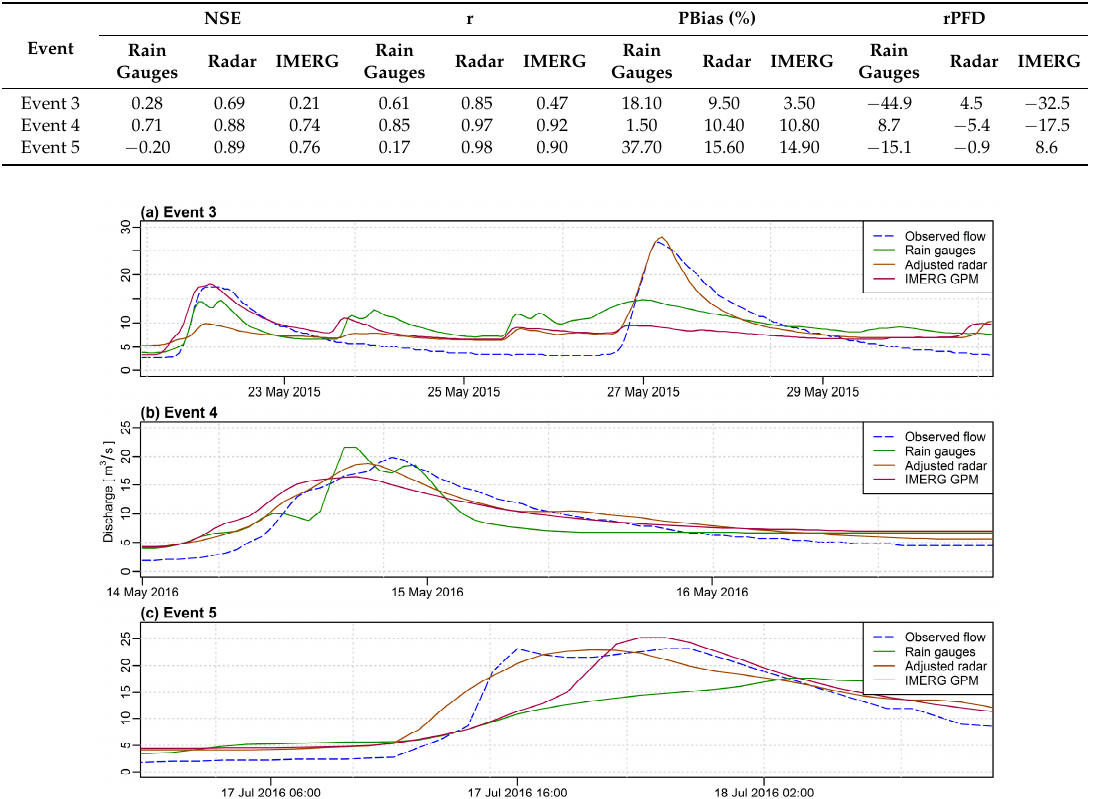
Figure 7. Comparison of simulated and observed hydrographs for the validation events ( a ) Event 3: 21–30 May 2015, ( b ) Event 4: 14–17 May 2016, ( c ) Event 5: 17–19 July 2016.